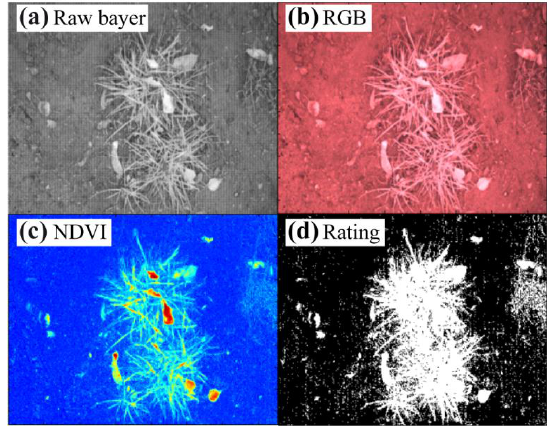
Figure 9. ( a ) Raw image of tufts of grass and leafs added by wind, ( b ) false color image, ( c ) NDVI image in rainbow colors from blue (zero) to red (256), and ( d ) binary image under stray light conditions and with a shutter time of 250 µs.